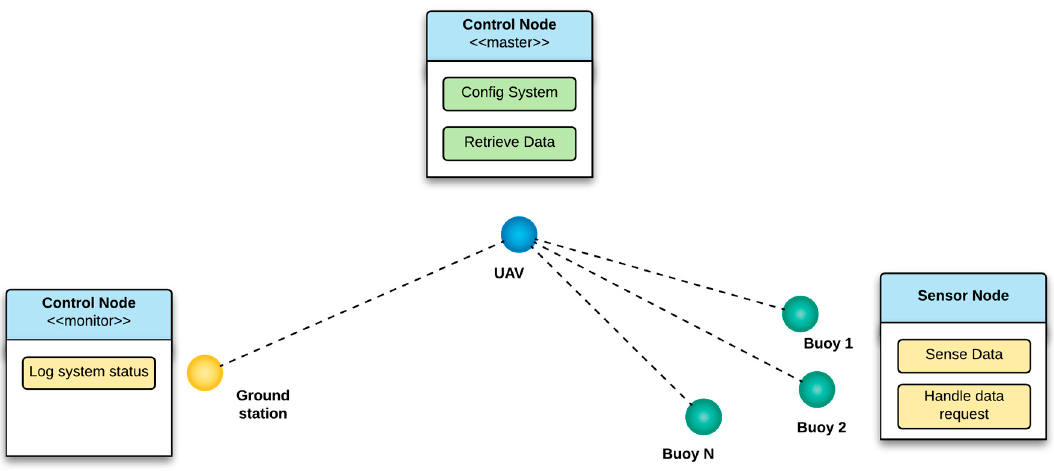
Figure 2. Functionality of the hardware developed for the SIMMA project.